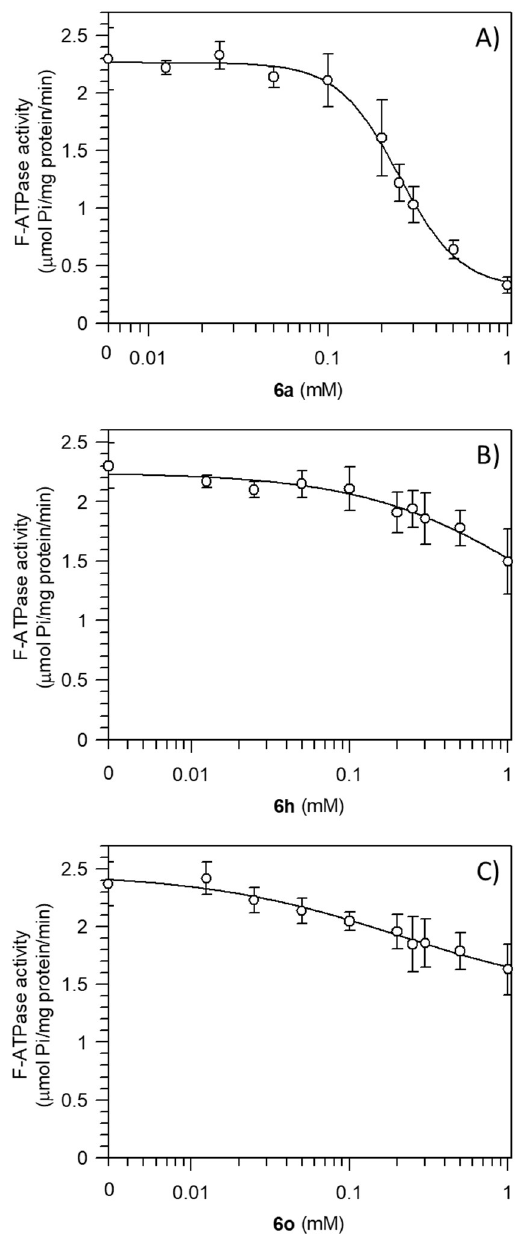
Figure 3. Effect of pyrazole derivatives 6a ( A ), 6h ( B ), and 6o ( C ) on the activity of mitochondrial F 1 F O -ATPase. F-ATPase activity is plotted against concentrations of Pzs (logarithmic scale). Data represent the mean ± SD from three independent experiments carried out on different mitochondrial preparations.